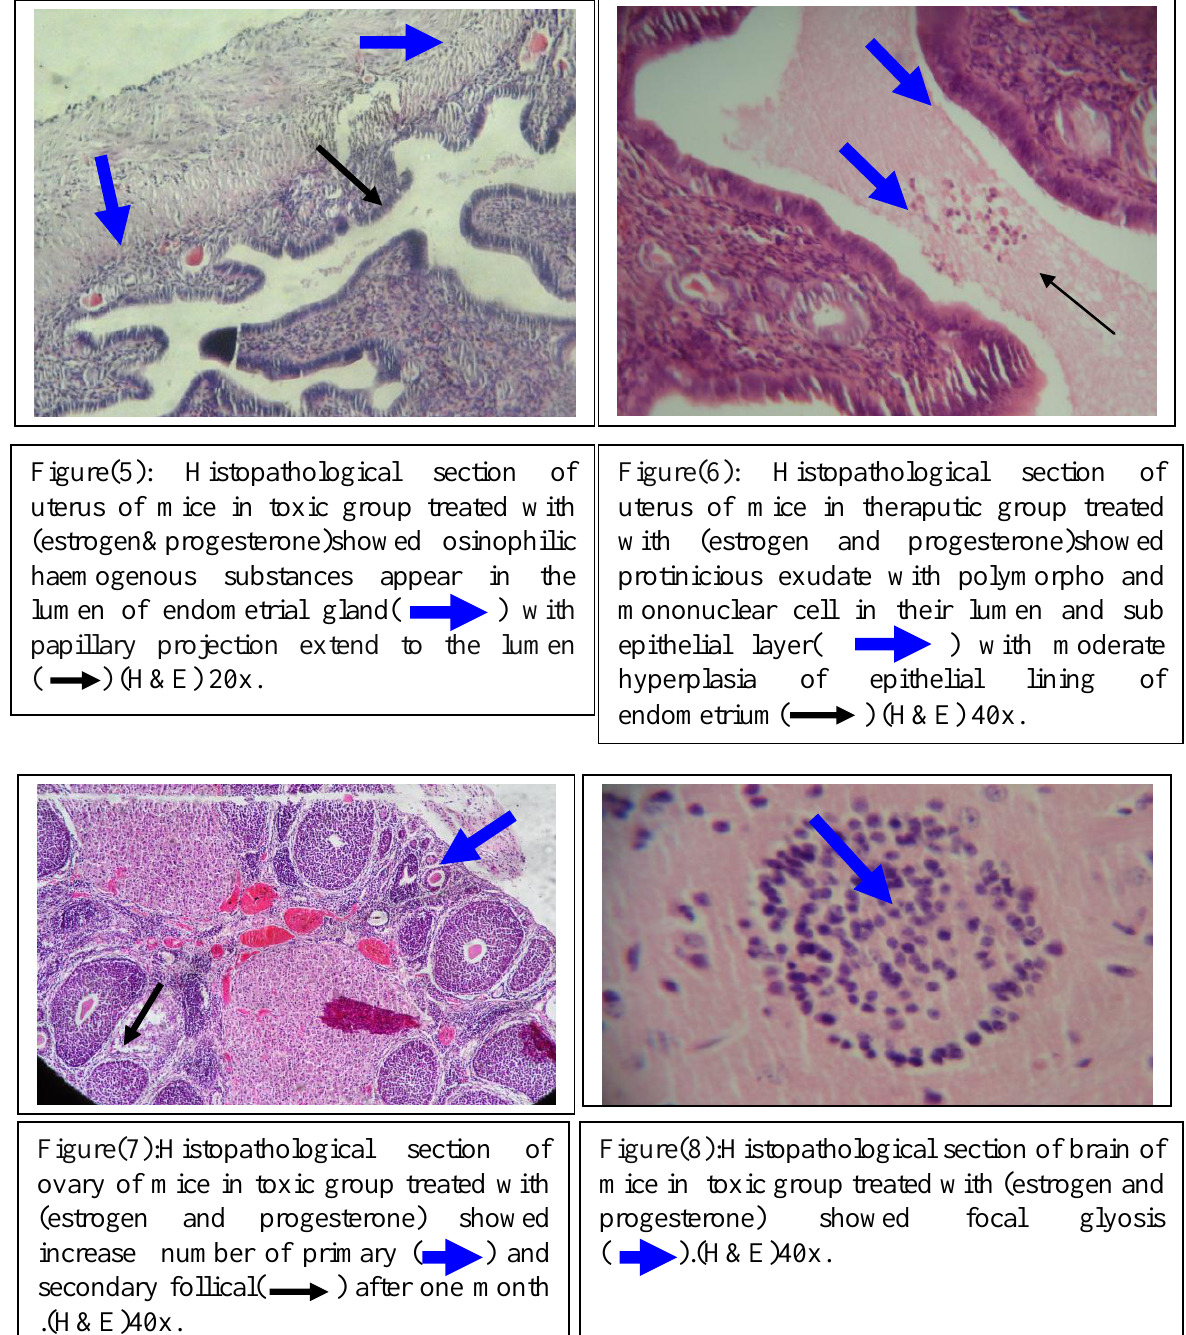
Figure(7):Histopathological section of Figure(8):Histopathological section of brain of mice in toxic group treated with (estrogen and showed progesterone) showed focal glyosis (